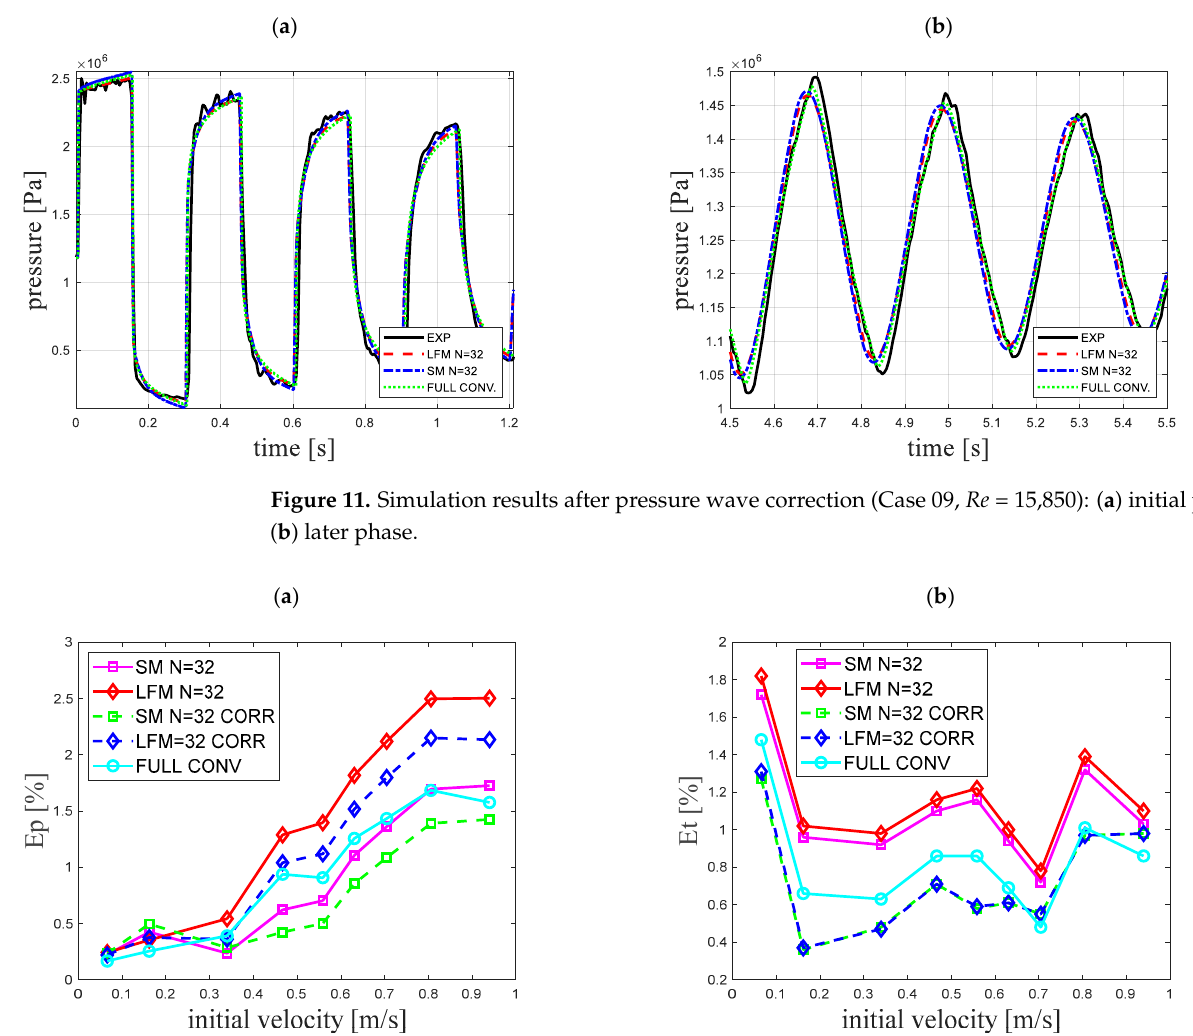
Figure 12. Variation in error coefficients: ( a ) Ep ; ( b ) Et .